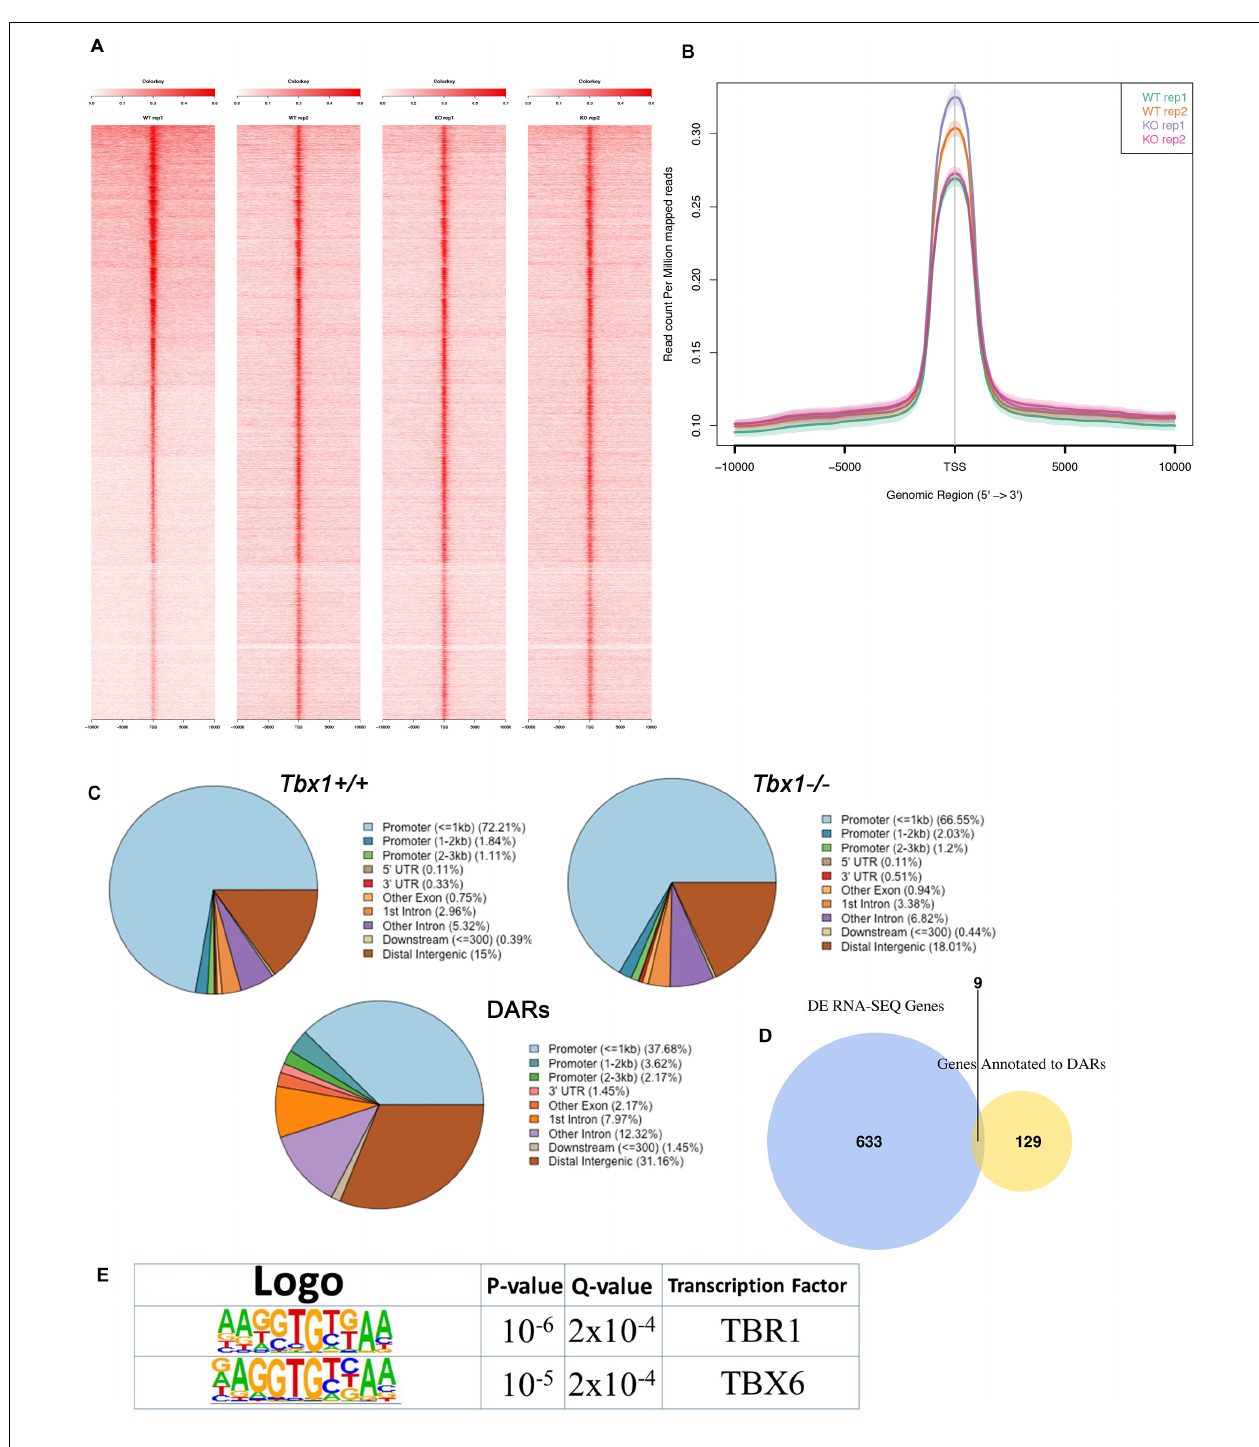
FIGURE 5 | ATAC-seq of PDGFRA+; KDR– differentiating mESCs at Day 4 of differentiation. (A) Heat maps of signal distribution around the transcription start site (TSS) ± 10000 bp of the 13075 expressed genes in two Tbx1 + / + (WT) and two Tbx1 − / − (KO) biological replicates. (B) Average profiles of enrichment at the TSS of the 13075 expressed genes in WT and KO cells. (C) Pie charts of the distribution of ATAC-seq peaks in WT (top left, number of peaks = 11362), KO (top right, number of peaks = 13622), and DARs (bottom, n = 138) relative to gene features. Note that as for P19Cl6, the DARs are relatively less enriched in the promoter region, and more enriched in the distal intergenic regions. (D) The Venn diagram intersects DEGs with genes associated with DARs. There were nine genes in common between the two groups. (E) Logos of the most enriched known motifs in the 138 DARs. The two consensus sequences are almost identical and reproduce a typical T-BOX binding